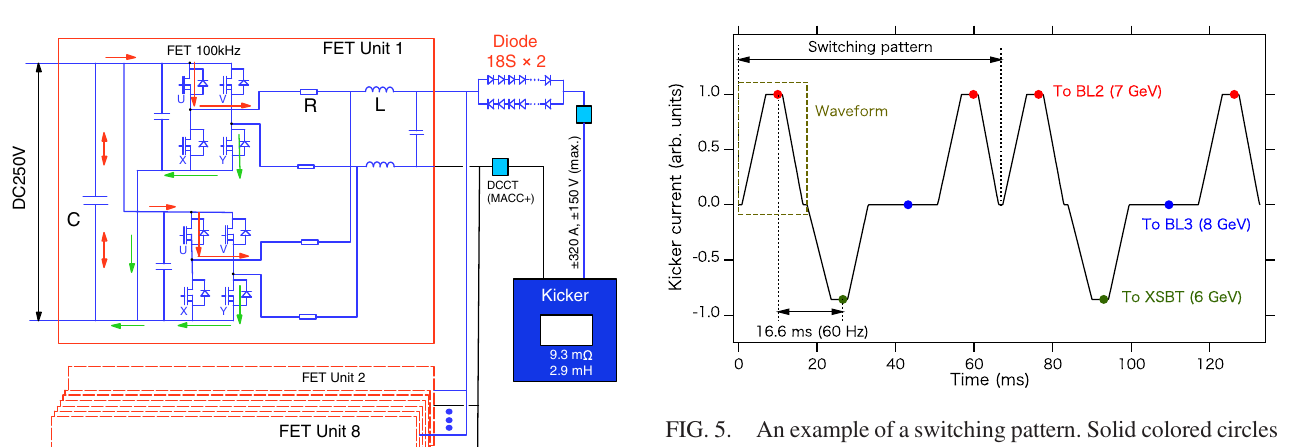
FIG. 5. An example of a switching pattern. Solid colored circles show the arrival timing of 60 Hz electron bunches. Half of the bunches, whose energy is 7 GeV, are deflected to BL2 (red circles). A quarter of them, having 6 GeVenergy, are deflected to XSBT (green circles), and the rest of the bunches travel straight through the kicker magnet to BL3 with 8 GeV (blue